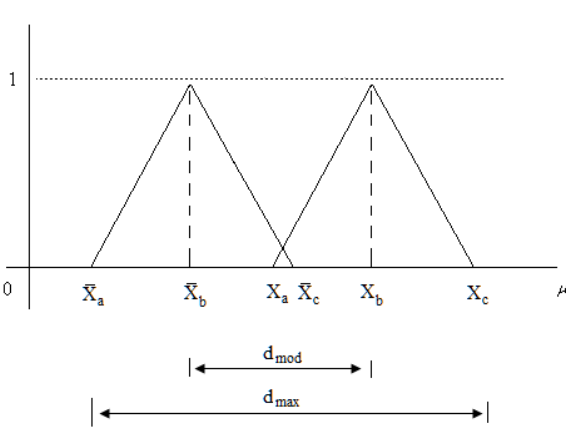
Fig. 5. The mod and the largest distance of the fuzzy number value and the fuzzy